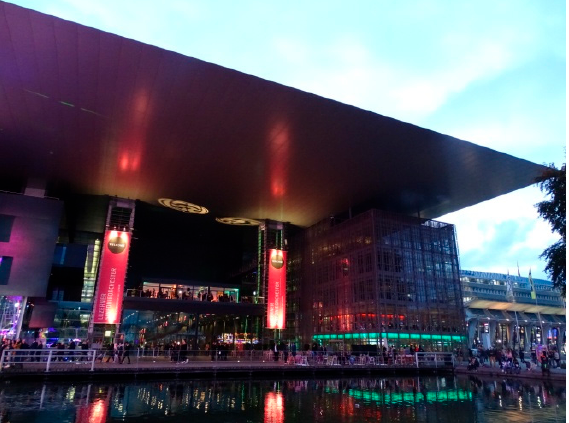
Figure 8. Façade of Kultur- und Kongresszentrum Luzern viewed from Europaplatz (Europe Square), photograph by B. Majerska-Pa ł ubicka.